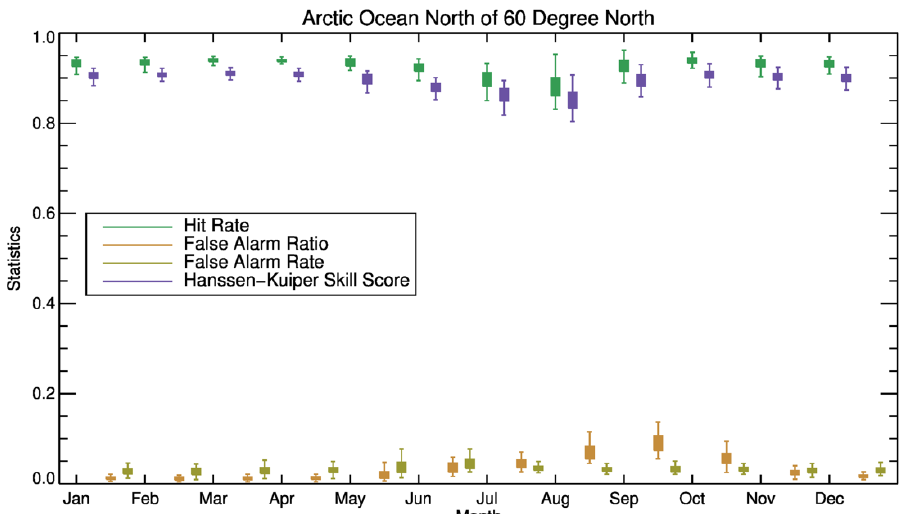
Figure 6. Monthly mean Hit Rate, False Alarm Ratio, False Alarm Rate, and Hanssen-Kuiper Skill Score over the Arctic Ocean poleward of 60 ◦ North, where AMSR2 ice mask compares to IMS ice mask. The solid box shows the interquartile range (25% to 75%), and the whiskers extend out the maximum and minimum value of the monthly means.